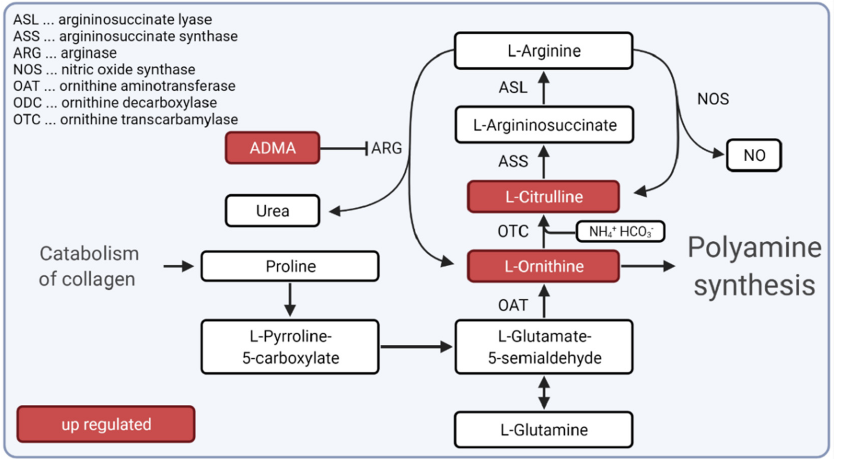
Figure 5. Hypotheses for the role of urea cycle during inflammation and fibrosis in SSc. Our hypothesis suggests that the urea cycle is fueled by collagen catabolism during SSc. Metabolites citrulline and ornithine and dimethylarginine (depicted as ADMA), which is known to inhibit arginase (ARG), were up-regulated in SSc patients. Created with BioRender.com (accessed on 31 December 2021).